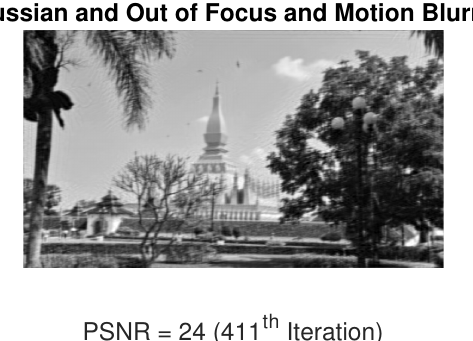
Figure 41. The reconstructed grey image of all cases using the proposed method (2) with PSNR = 24.